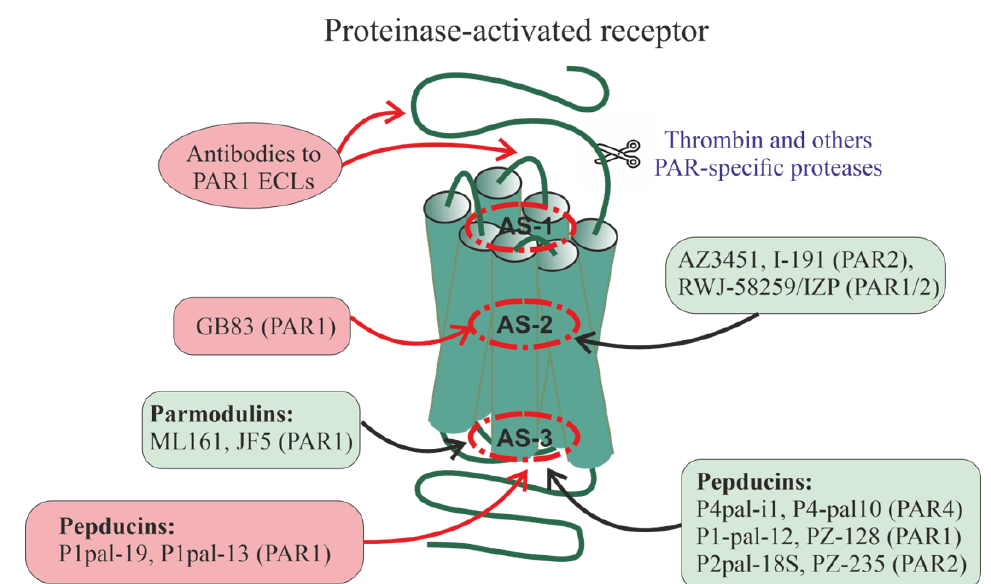
Figure 3. Allosteric regulation of proteinase-activated receptors. There is now evidence of allosteric regulation and localization of allosteric sites for PAR1, PAR2, and PAR4. As in the case of chemokine receptors (see Figure 2), allosteric sites in PARs can be located at different TMD loci (AS-1, AS- 2, and AS-3) in the ECLs where they are available for interaction with autoantibodies, as well as in the ICLs where they are targets for pepducins. The small compounds, such as GB83 (PAR1- selective PAM), AZ3451 (allosteric PAR2-inhibitor), I-191 (PAR2-selective NAM), and cross-linked heterobivalent allosteric PAR1/PAR2 inhibitor, RWJ-58259/imidazopyridazine (IZP) derivative), interact with allosteric sites located in the upper and central parts of the TM7 bundle. The low- molecular-weight parmodulins, including the PAR1-allosteric inhibitors ML161 (PM2) and JF5, as well as pepducins, interact with intracellular sites, including the AS-3 locus. The following pepducins have been obtained and have specific activity for PAR1, PAR2, and PAR4: Palm-SGRRYGHALR (P4pal-10) (ICL3 of PAR4, allosteric PAR4-antagonist and NAM and allosteric antagonist for the non- cognate receptors PAR1, FPR2, and FFAR2), Palm-ATGAPRLPST (P4pal-i1) (ICL1 of PAR4, allosteric PAR4-inhibitor), Palm-RCLSSSAVANRS (P1pal-12), Palm-RSLSSSAVANRS (P1pal-12S) and its analog P1pal-7 (PZ-128) (ICL3 of PAR1, allosteric PAR1-antagonists), Pal-RCLSSSAVANRSKKSRALF (P1pal- 19), Palm-AVANRSKKSRALF (P1pal-13) (ICL3 of PAR1, full allosteric PAR1-agonists), and Palm- RSSAMDENSEKKRKSAIK 270 − 287 (P2pal-18S) and its analog PZ-235 (ICL3 of PAR2, allosteric PAR1/2- antagonists). Data on autoantibodies to PARs are fragmentary, but antibodies to extracellular regions of PAR1 in patients with systemic sclerosis have been shown to function as PAR1-specific allosteric full agonists and/or PAMs. Many of the effects of allosteric regulators are due to their effect on the stability of heterodimeric PAR1/PAR2 complexes, as shown for the heterobivalent PAR1/PAR2- inhibitor and pepducins P1pal-12S and P2pal-18S. Allosteric regulators that increase receptor activity (full agonists and PAMs) are placed in red squares, while allosteric regulators that decrease receptor activity (antagonists and NAMs) are placed in green